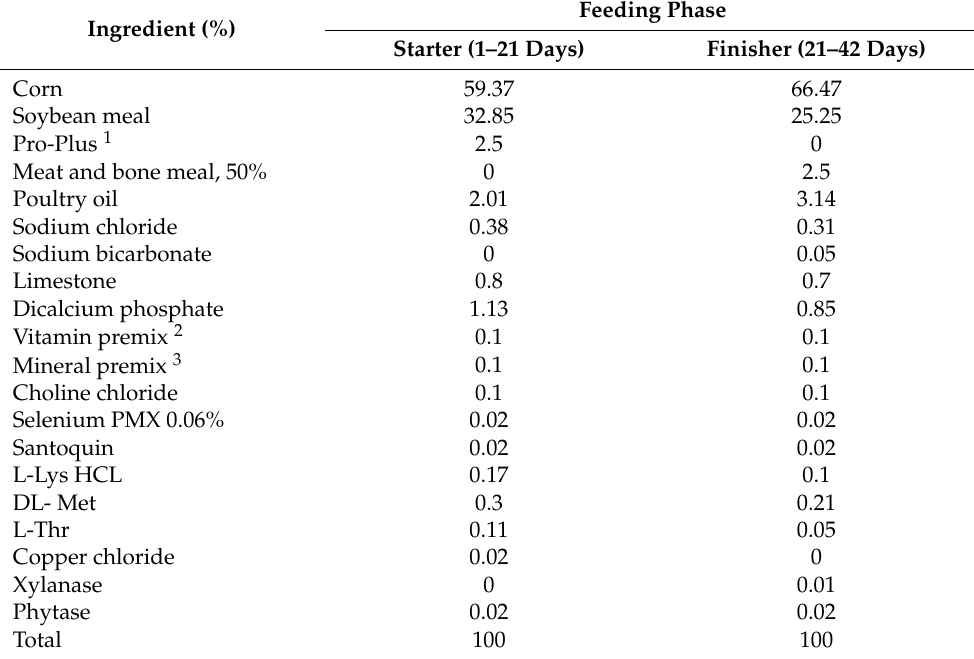
Table 1. Ingredient composition (% as fed) of the experimental basal diet. Ingredient